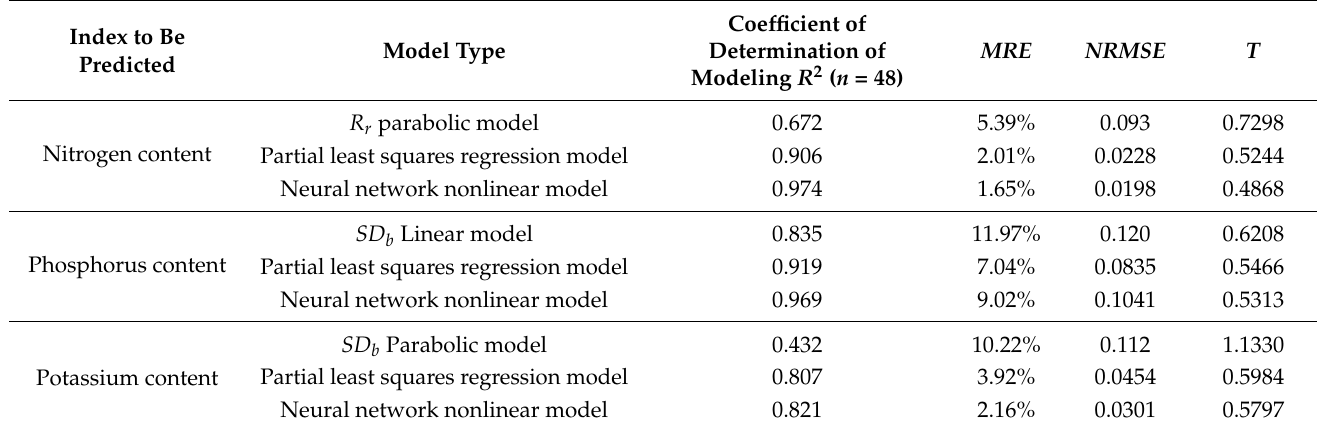
Table 6. Comparison of spectral characteristic model, partial least squares model and neural network model